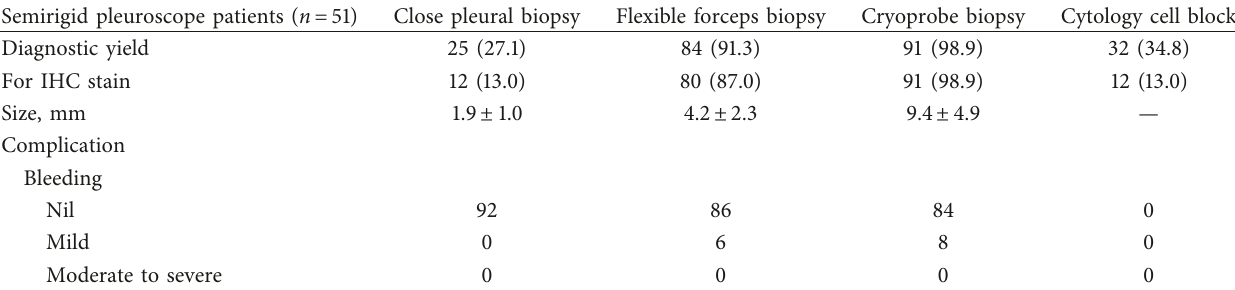
Table 3: The diagnostic yield, size, and quality of samples and complications.